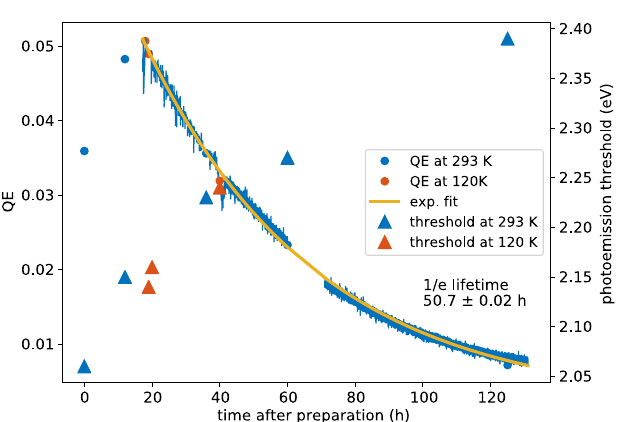
FIG. 6. Lifetime in terms of QE at 2.4 eV of sample P016. The data points are extracted from spectral response measurements while the blue curve represents a continuous measurement.